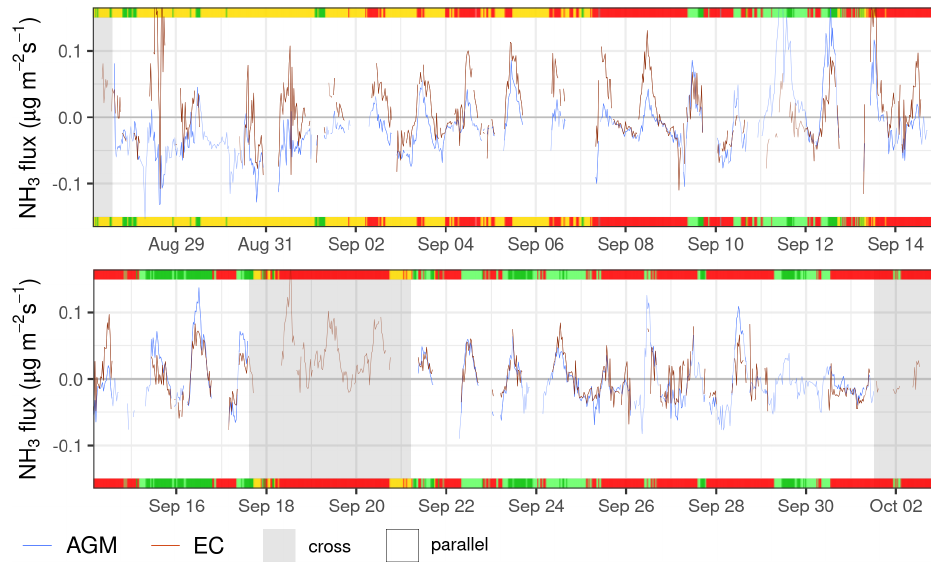
Figure 7. Time series of the NH 3 fluxes of AGM with miniDOAS instruments (blue) and the EC method from the HT (red). Positive fluxes indicate emissions, negative fluxes deposition. The colours in the upper and lower borders indicate the prevailing wind directions from Fig. 1. The intercalibration periods for the miniDOAS instruments are shown against a grey background. The thick lines indicate the NH 3 fluxes that were left for intercomparison after all filters were applied.